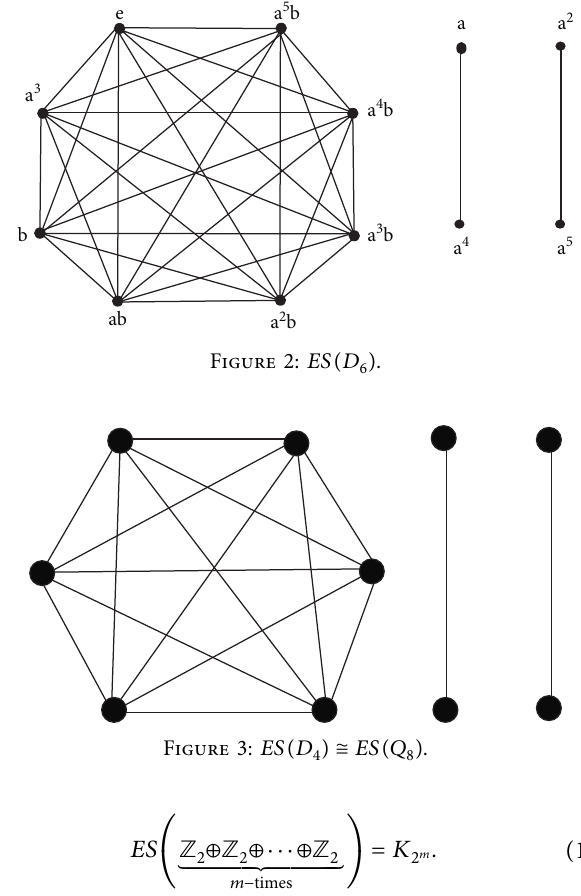
Table 1: Equal-square graph of abelian group of order 36000.